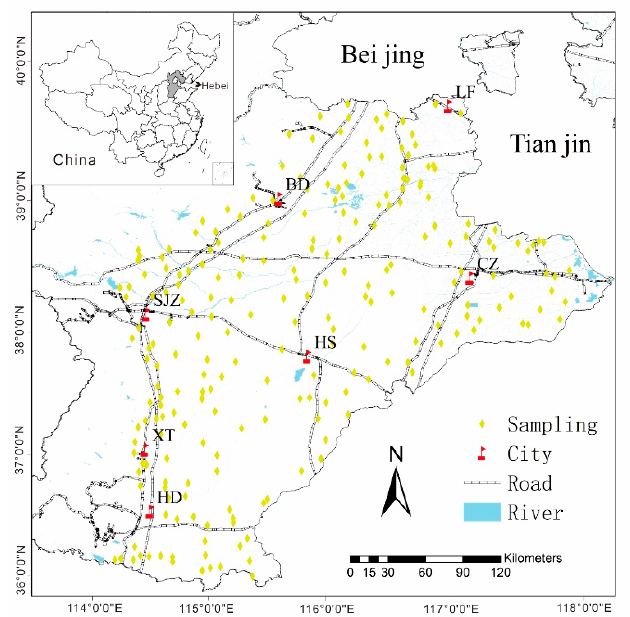
Figure 1. The sampling sites of wheat and corresponding soil in the study area. (BD: Baoding City, LF: Langfang City, CZ: Cangzhou City, SJZ: Shijiazhuang City, HS: Hengshui City, XT: Xingtai City, HD: Hangdan City). Water and wheat can lead to health risks in humans; air and soil do not pose health risks to humans. The arrows represent the relationship between each media.